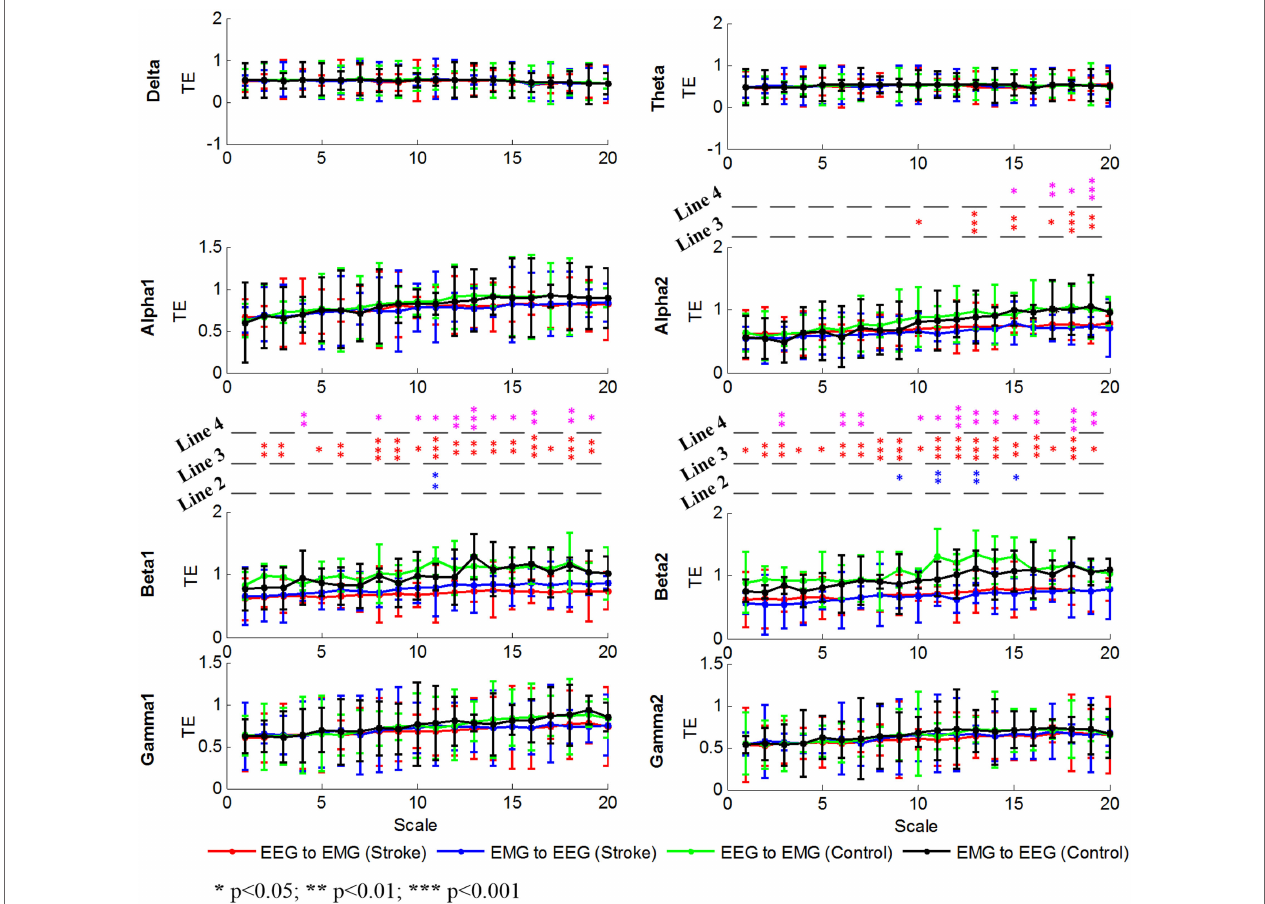
FIGURE 5 | Grand averages of the MSTE values in both descending and ascending directions for all subjects at delta, theta, alpha1, alpha2, beta1, beta2, gamma1, and gamma2 bands, respectively. We denoted the significance with the star mark. * p < 0.05, ** p < 0.01, and *** p < 0.001. The word “Line 1” showed the significant level between descending and ascending direction in each time scale for stroke patients, the word “Line 2” was for healthy controls. The Line 3 and Line 4 indicated the significant level between stroke patients and healthy controls at each time scales in descending and ascending directions,